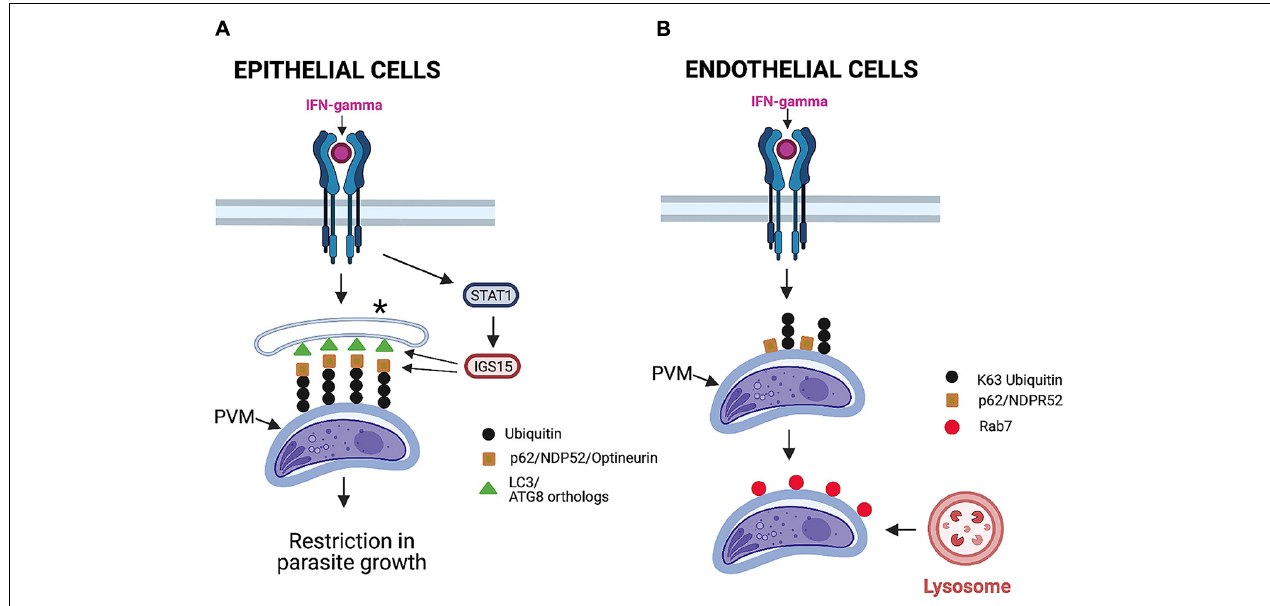
FIGURE 5 | Mechanisms induced by IFN- γ to restrict T. gondii in human cells. (A) In epithelial cells, IFN- γ promotes deposition of ubiquitin, adaptor proteins (p62, NDPR52, and optineurin), and LC3 around parasitophorous vacuole membrane (PVM). STAT1-dependent upregulation of ISG15 stimulates deposition of adaptor proteins around PVM. This process is independent of Beclin 1 and does not cause vacuole lysosomal fusion. Instead, it results in entrapment of parasitophorous vacuole by multilayer membrane structure (*) and inhibition of parasite growth. (B) In endothelial cells infected with a type II strain of T. gondii , IFN- γ induces deposition of ubiquitin, p62, and NDPR52. This is followed by recruitment of Rab7, fusion with lysosomes, and parasite killing. Importantly, LC3 is not recruited around PVM, and this process is not dependent on key autophagy molecule ATG16L. Figure was generated using